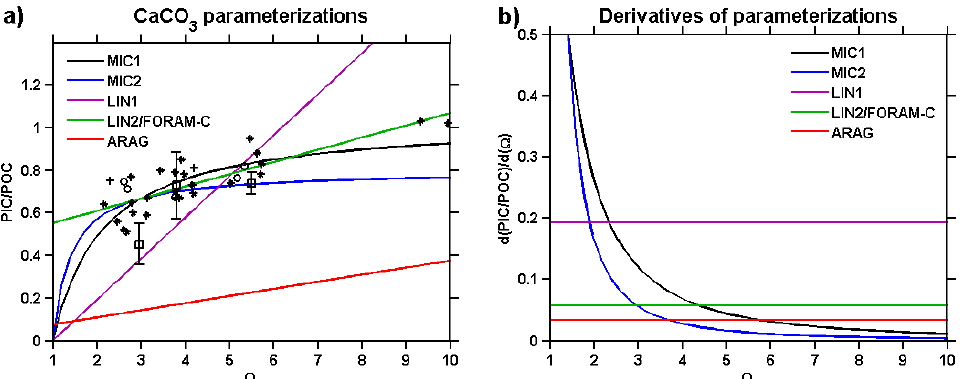
Fig. 1. PIC-POC ratio (a) as a function of calcite saturation state with respect to ambient waters. Data from Delille et al. (2005) are shown as black squares with error bars, from Zondervan et al. (2002) as black asterisks, data from Iglesias-Rodriguez et al. (2008) are shown as black circles and data from Shi et al. (2009) as black crosses. Three new parameterizations are fitted to the data and used in the Bern3D/PISCES model to compute CaCO 3 production: a Michaelis-Menten curve (MIC1), a linear curve that is forced to go through (cid:127) C = 1 (LIN1) and a linear curve that was freely fitted to the data (LIN2), which is also used for calcite production by mesozooplankton (FORAM-C). In addition, the Michaelis-Menten curve that was used in Gehlen et al. (2007) and Gangstø et al. (2008) is included (MIC2). The red curve denotes the parameterization used for aragonite production (ARAG). The respective sensitivities, d (PIC-POC)/ d(cid:127) , are shown in (b)